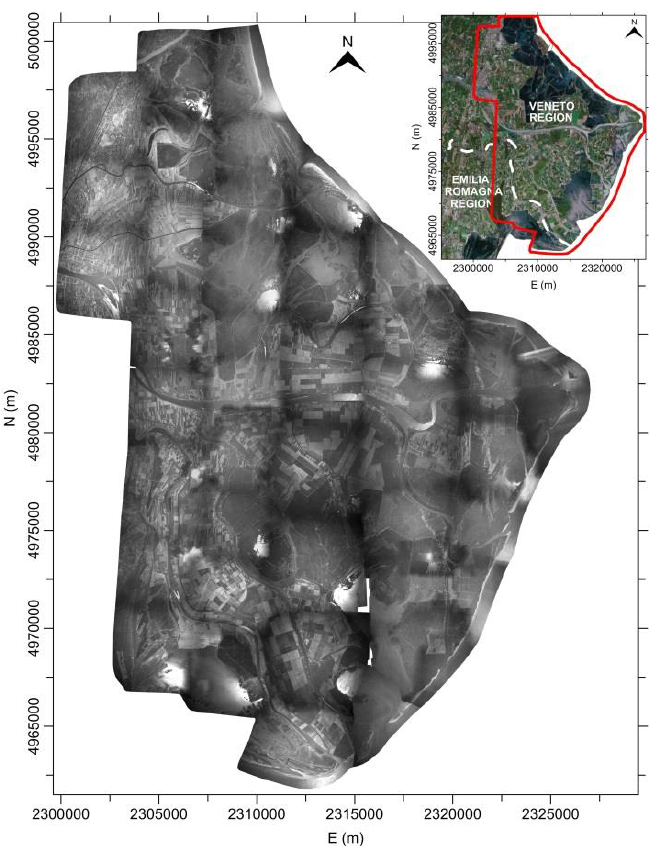
Figure 5. Photo-plan mosaic of the 1949 aerial photogrammetric survey: available images cover most of the PRD area in Veneto region and a portion of the Emilia Romagna region; visibility on aerial photographs increases, although not yet optimal.